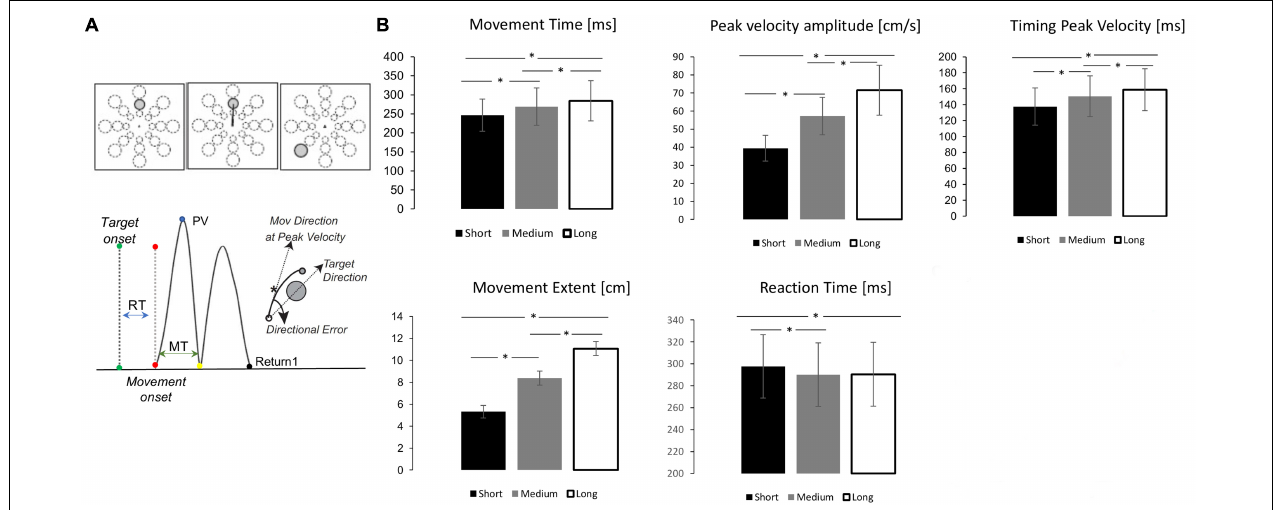
FIGURE 1 | Mov test depiction, kinematic indexes and performance. (A) Top. mov test. One of 24 targets appeared in unpredictable order every 3 s. Bottom. Measures of movement characteristics. (B) Mean and standard error for each target distance (Black = short, Gray = medium, White = Long) for the kinematic parameters. The horizontal lines and asterisk ( ∗ ) significant pairwise comparisons after Bonferroni correction ( p < 0.05).